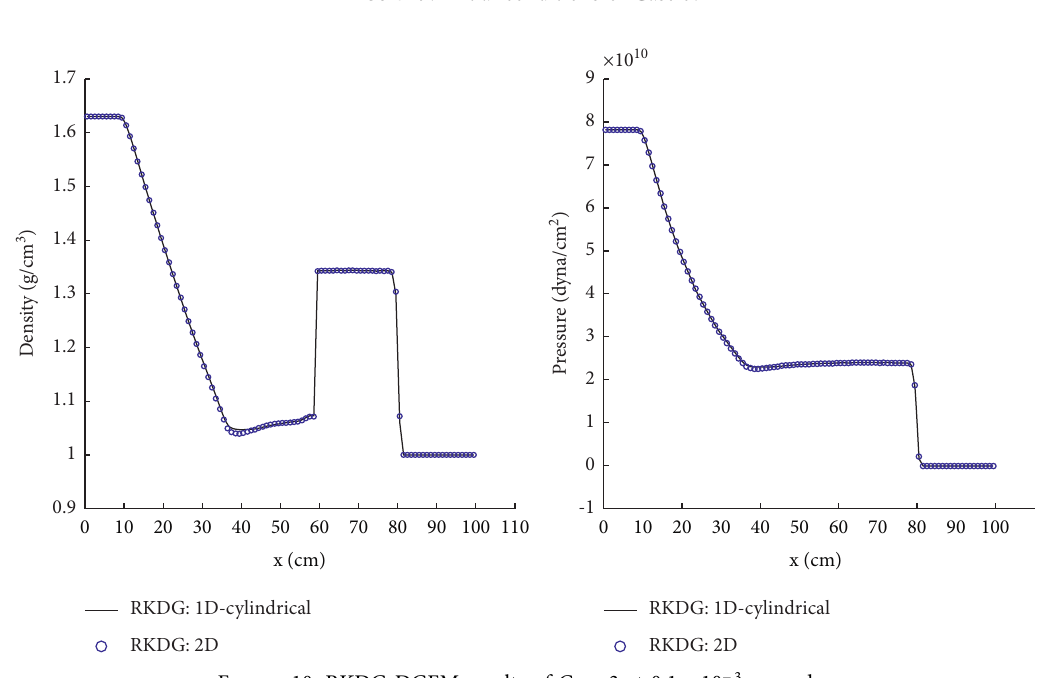
Figure 10: RKDG-DGFM results of Case 3 at 0 . 1 × 10 − 3 seconds. Contours of density and pressure are plotted in Fig- ure 11. Results are consistent with the xy -plots of the 2D results in Figure 10. No contour distortion occurs and symmetry is good.